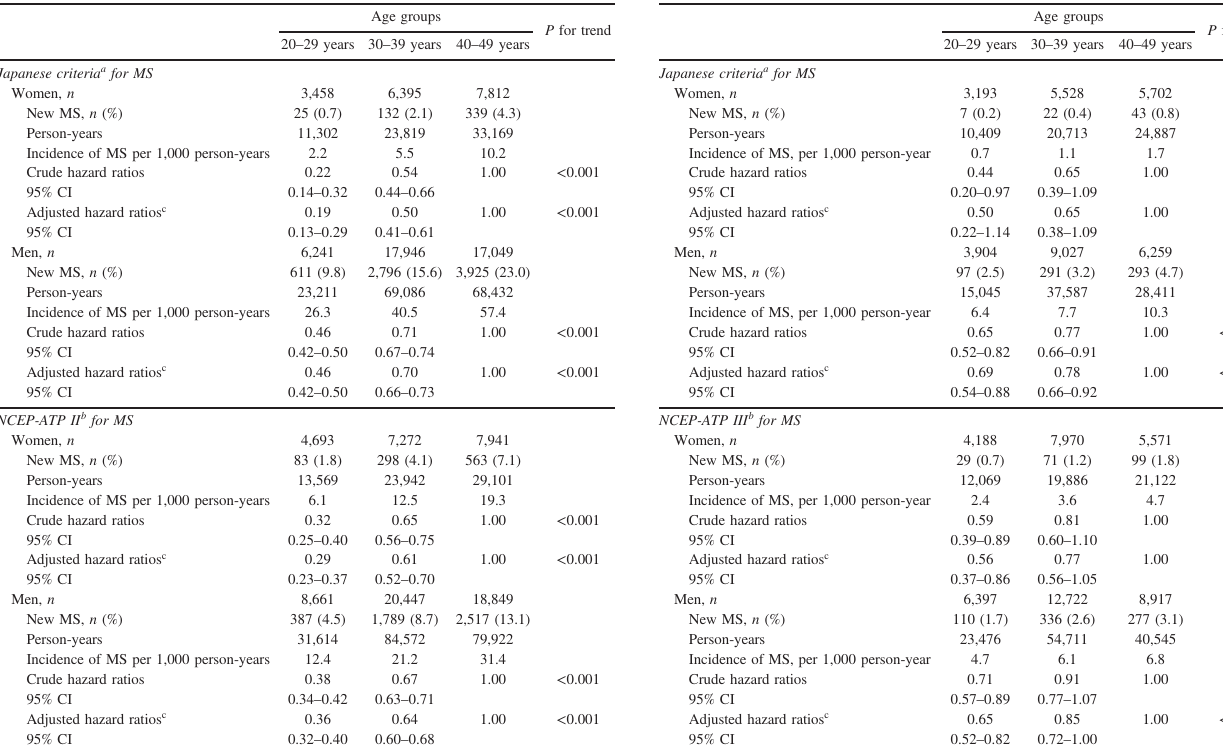
NCEP-ATP II b for MS Women, n